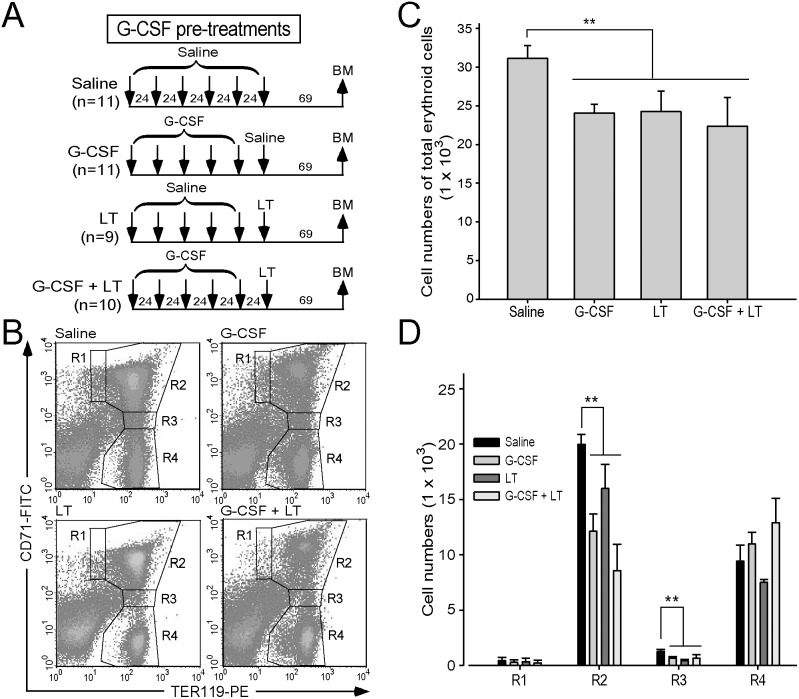
Regulation of G-CSF on bone marrow erythroblast populations.The experimental outlines are illustrated (A). Mice were treated with saline (n = 11), G-CSF (n = 11), LT (n = 9), or G-CSF plus LT (n = 10). Flow cytometry analysis analyzed erythroblast populations of BM cells at 69 h after LT challenges. The erythroblast cells were gated as R1 (CD71high, TER-119med), R2 (CD71high, TER-119high), R3 (CD71med, TER-119high), and R4 (CD71low, TER-119high) in all groups (B) as described [25]. The cell numbers of all erythroblast cells (sum of R1 to R4) (C) and individual erythroblast (R1, R2, R3, and R4) (D) in each group were quantified. **P<0.01 was compared between indicated groups. Data are showed as mean ± SD and represent the results from 2 independent experiments.